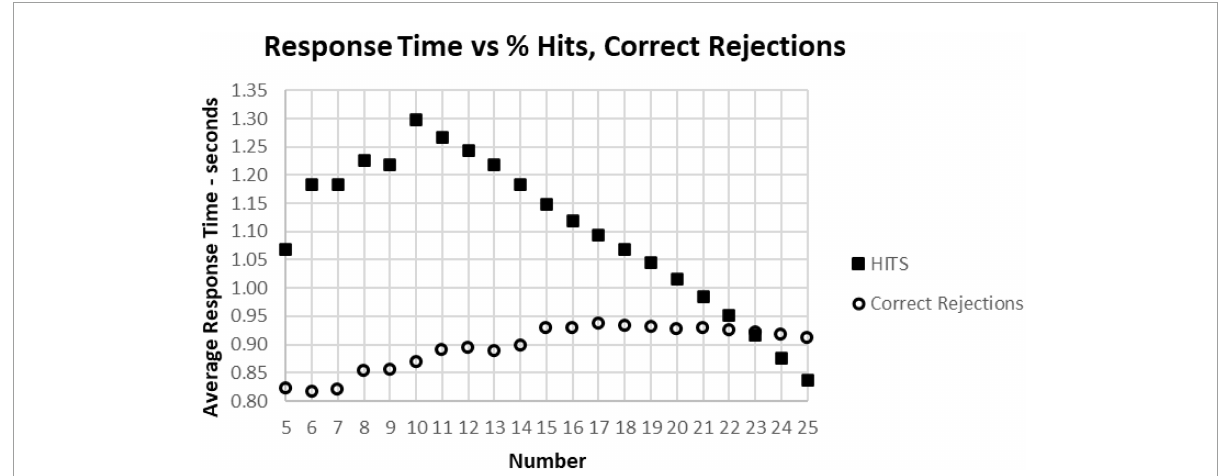
FIGURE13 The average correct response times broken down into True Positive and True Negative groups. Note that the number of True Positive responses has a clear linear relationship with the average response time. The True Negative choices have very little effect when there are more than 15 (less than 10 false positive responses), but they have a negative relationship with RT below 15, suggesting that the increased number of false responses is related to making faster incorrect responses.